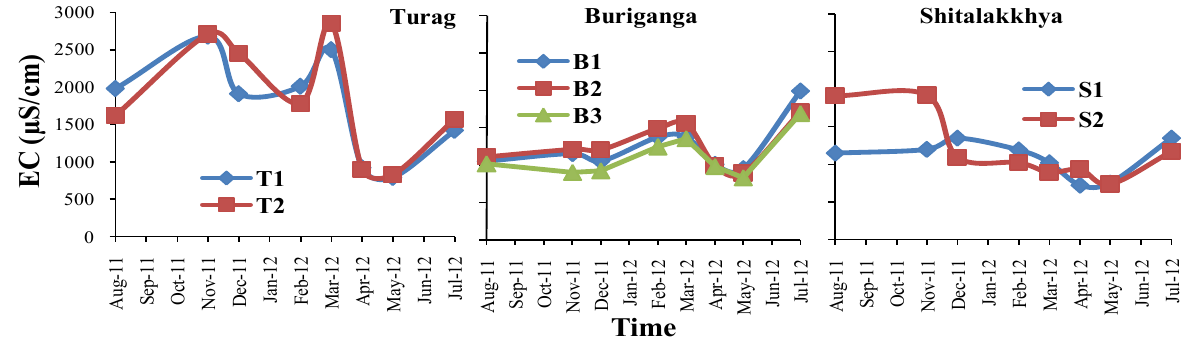
Figure 5. The electrical conductivity (EC) values of the samples from the water of three different rivers around Dhaka City.